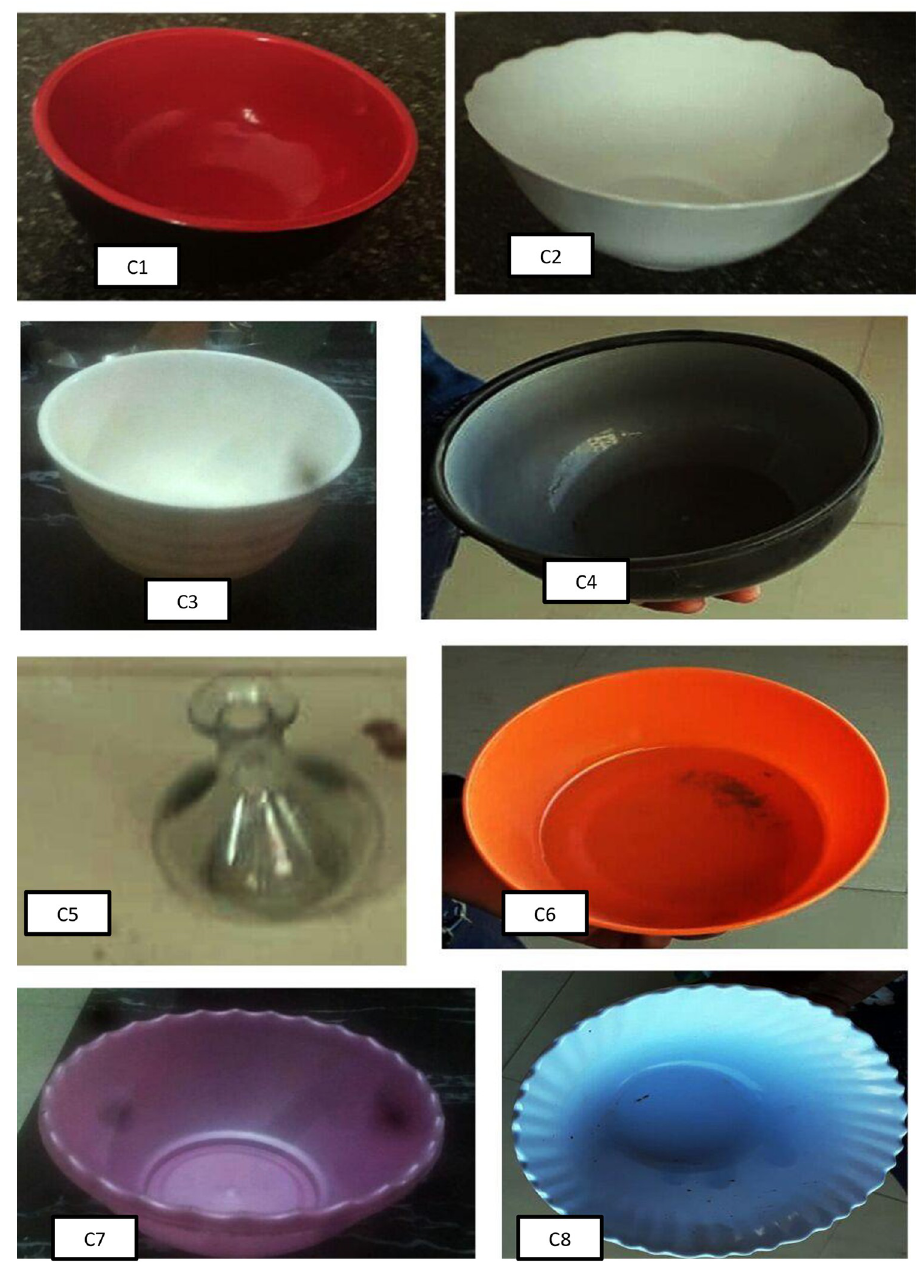
field carefully every day, used photograph banners of household apparatuses for portion